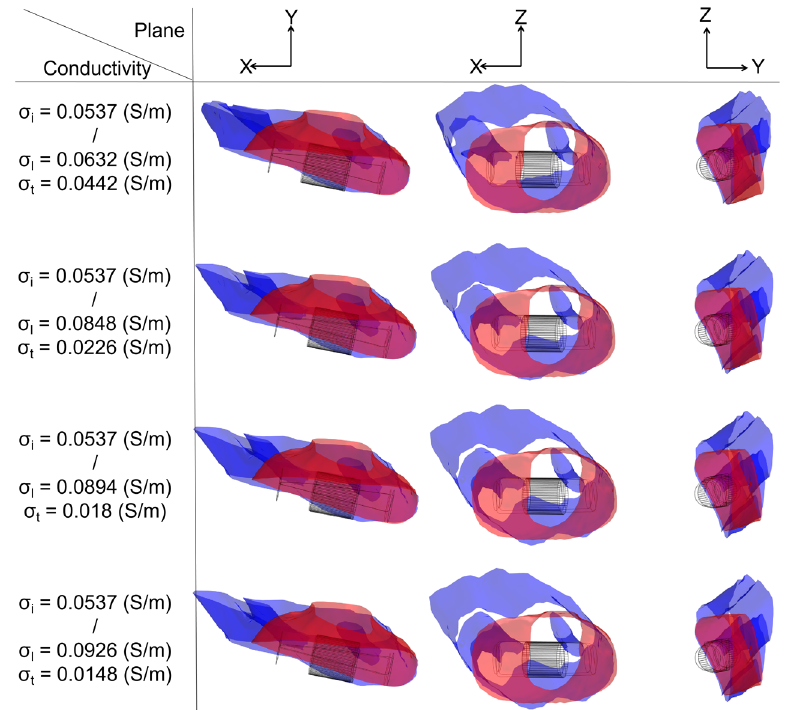
Figure 13. Under the condition of the PFA, the amplitude is 1000 V; at ablation target 3, the ablation isosurface distribution is generated by different ACs and ICs.